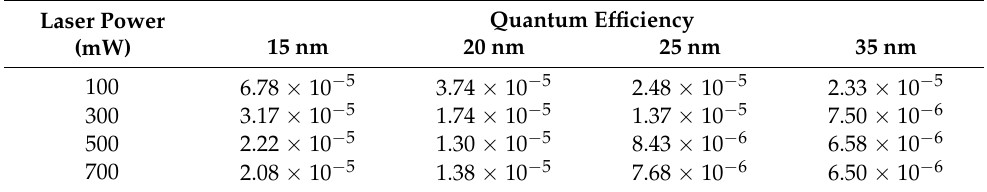
Table 1. Summarized quantum efficiency as a function of laser power for Au NPs with varying